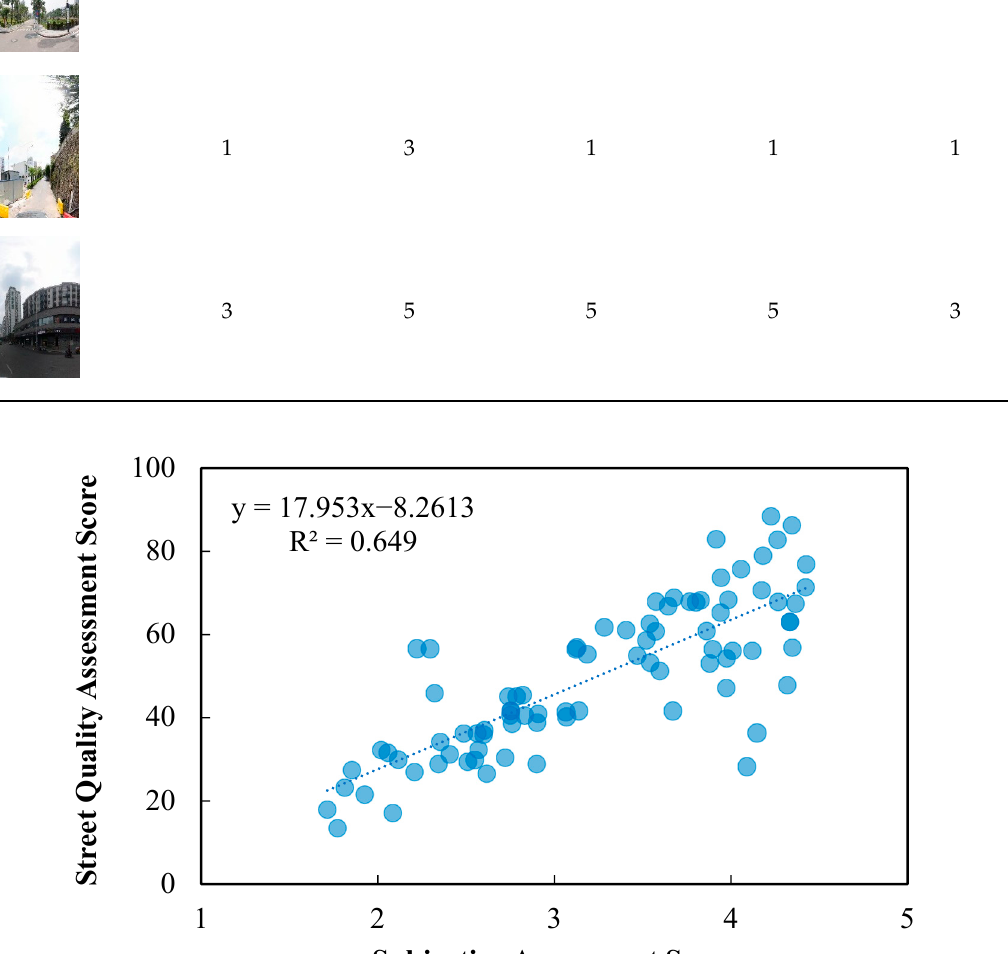
Figure 15. Relationship between street quality assessment score and subjective assessment score.